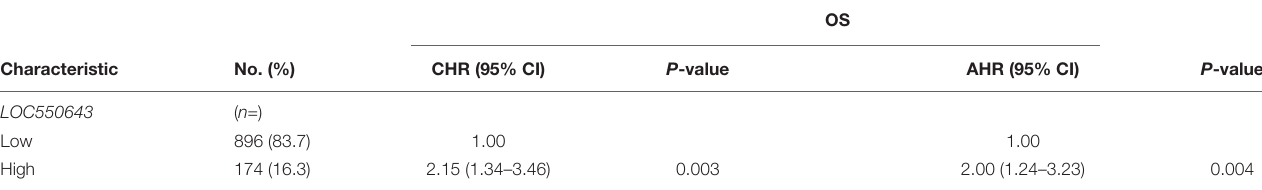
TABLE 2 | Univariate and multivariate Cox’s regression analysis of LOC550643 and expression for overall survival of 1070 patients with breast cancer.